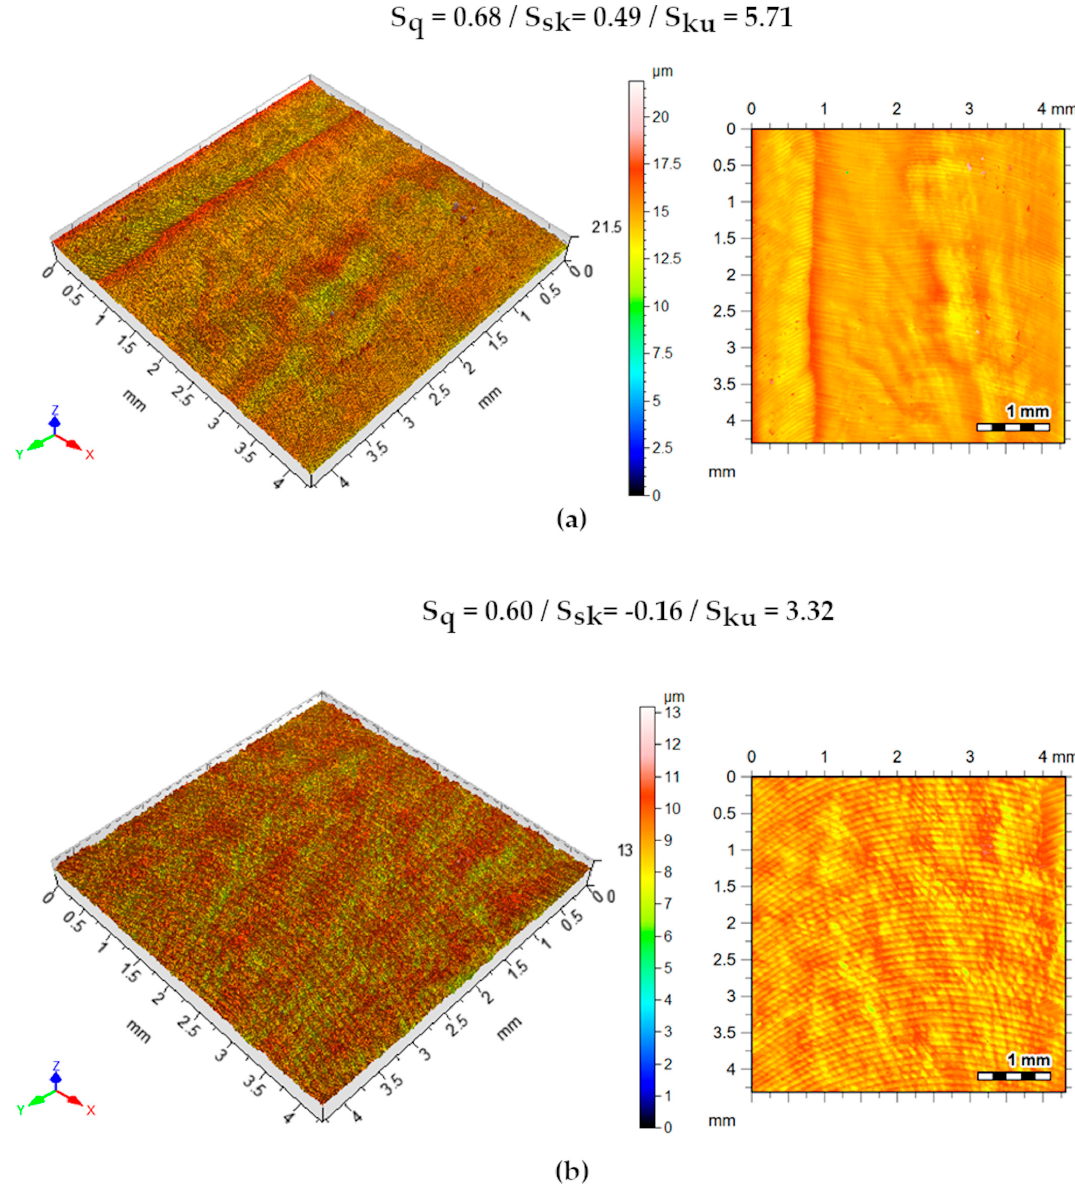
Figure 19. Machined surface topography. Isometric views and contour maps—oil strategy. ( a )v c = 80 m/min, a p = 0.5 mm, f = 0.06 mm/rev.; ( b ) v c = 100 m/min, a p = 1.0 mm, f = 0.1 mm/rev